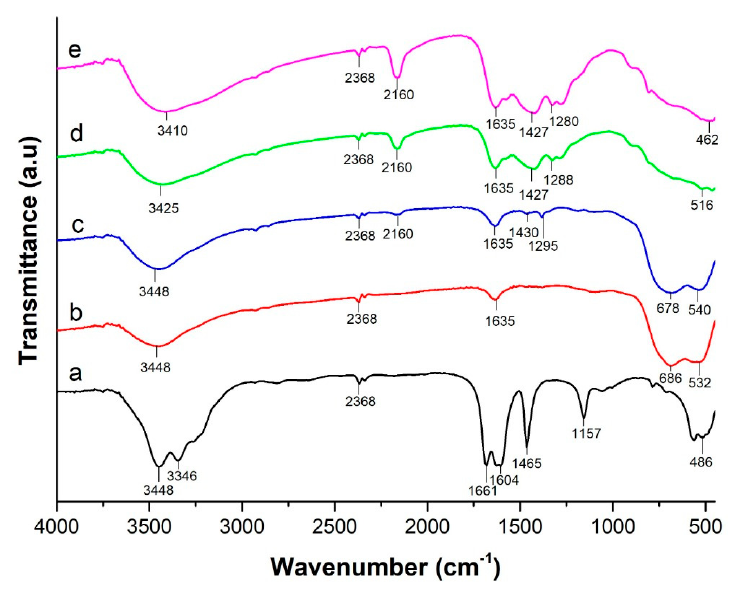
Figure 3. FTIR spectra of ( a ) urea, ( b ) TiO 2 , ( c ) TiO 2 –N (5), ( d ) TiO 2 –N (10) and ( e ) TiO 2 –N (15) .